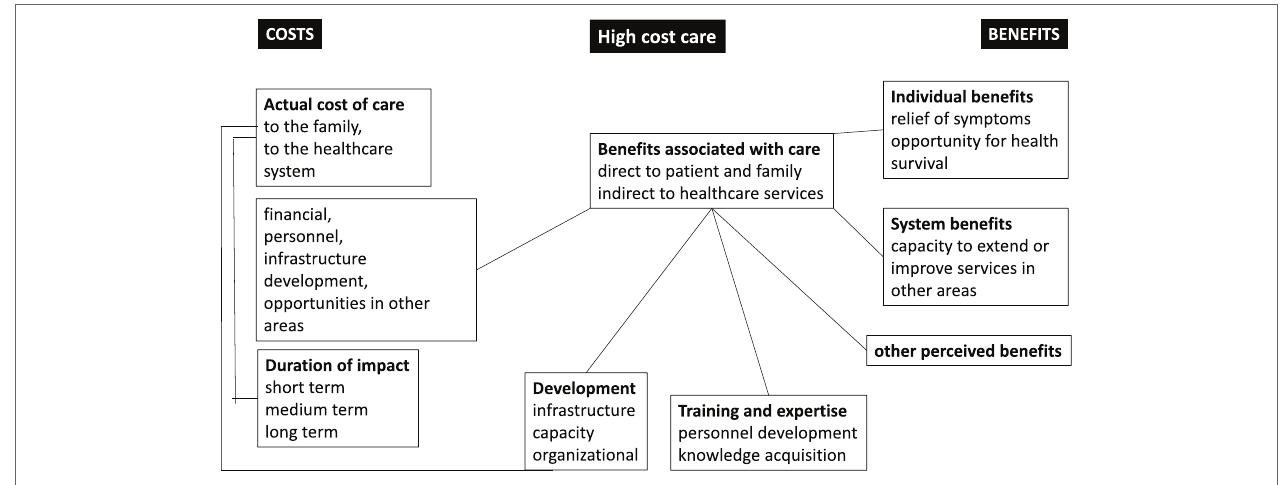
FiGURe 2 | The balances of costs and benefits for high-cost care (HCC) in low- and middle-income countries and low-income